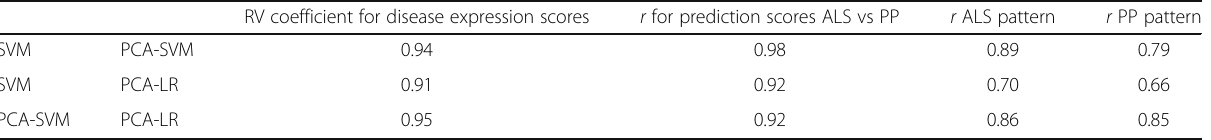
Table 3 RV coefficient between pairs of individual ALS- and PP-specific pattern expression scores (averaged over ten random iterations) as determined by SVM, PCA-SVM, and PCA-LR by projecting corresponding 18 F-FDG PET scans on a ALS- and PP-specific pattern respectively, combined with the Pearson correlation coefficient ( r ) between the individual projection scores, again averaged over ten random iterations, onto a discriminative brain pattern for ALS and PP (direct classification) for SVM, PCA-SVM, and PCA-LR. The voxelwise correlation coefficients between the ALS and PP metabolic brain patterns, determined by the different classifiers are also reported RV coefficient for disease expression